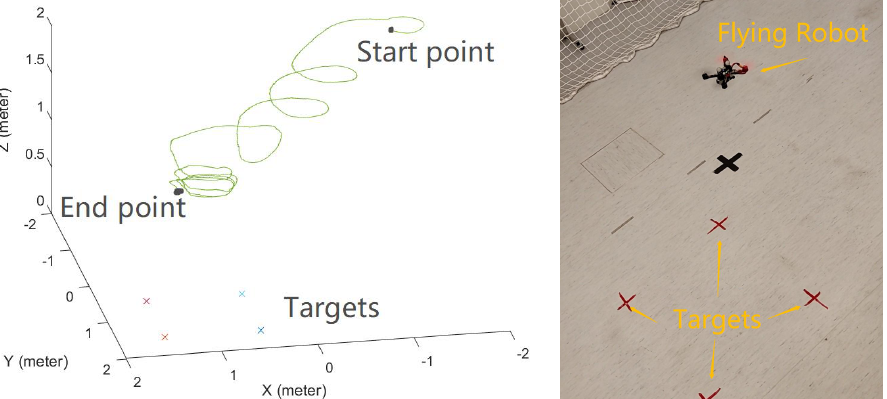
Figure 12. The 3D trajectory of flying robot and the screenshot of test video, link available at: https://youtu.be/s42ri834Nug (accessed on 11 September